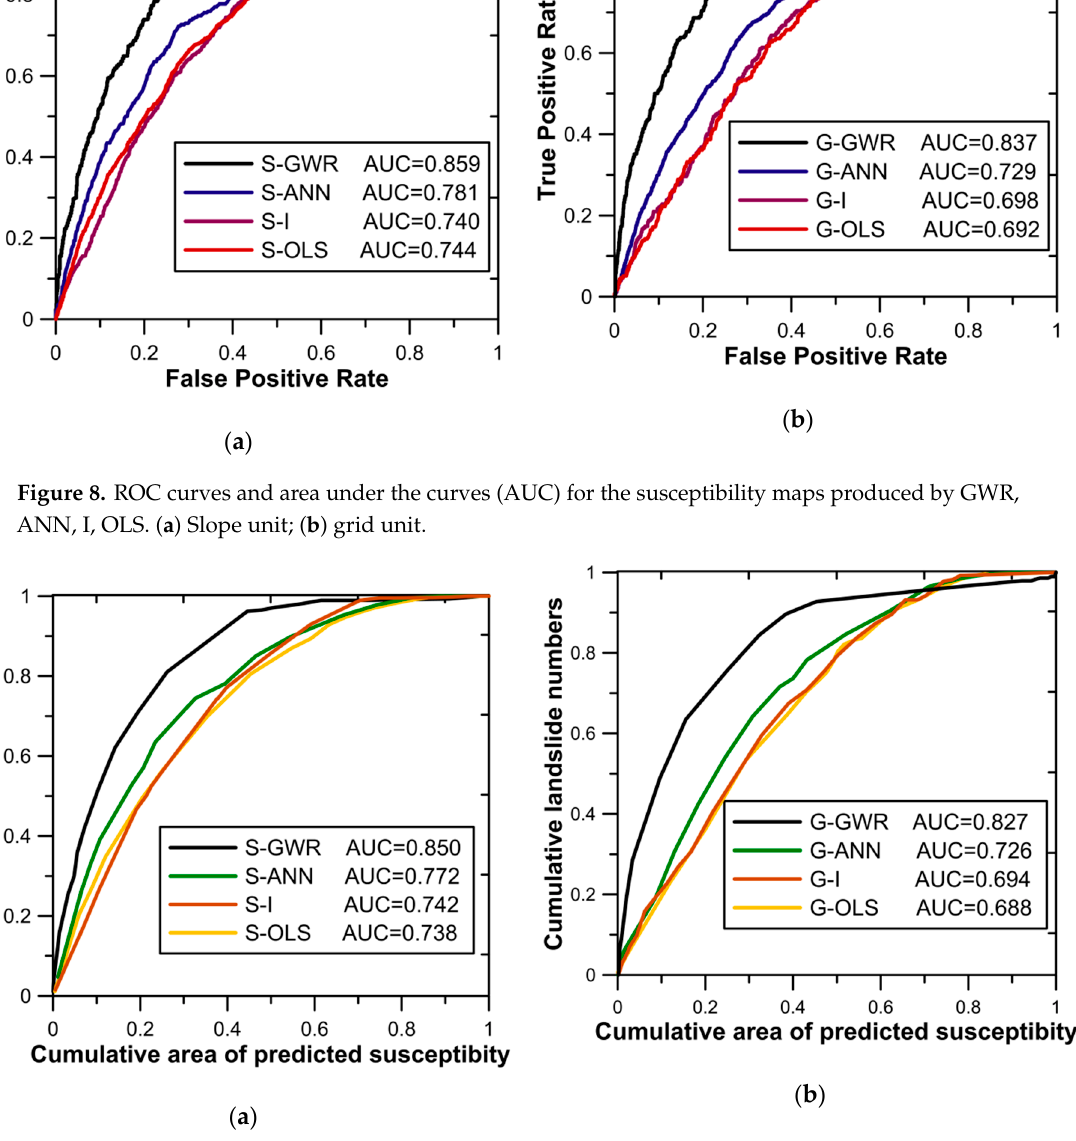
Figure 9. Success rate curves and area under the curves (AUC) for the susceptibility maps produced by GWR, ANN, I, OLS. ( a ) Slope unit; ( b ) grid unit.